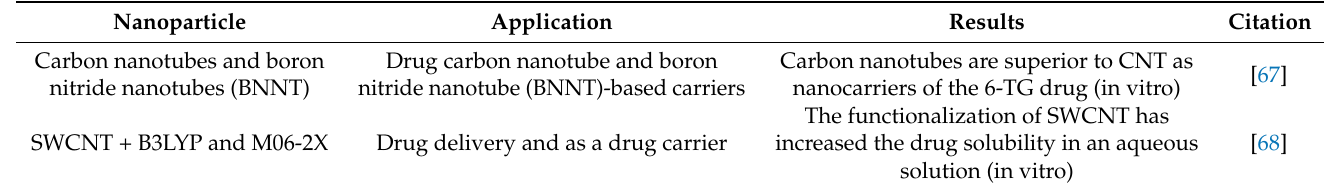
Figure 6. Carbon nanotubes and their application in cancer drug delivery and imaging. Table 8. Application of carbon nanotube-based nanomaterials as carriers in cancer